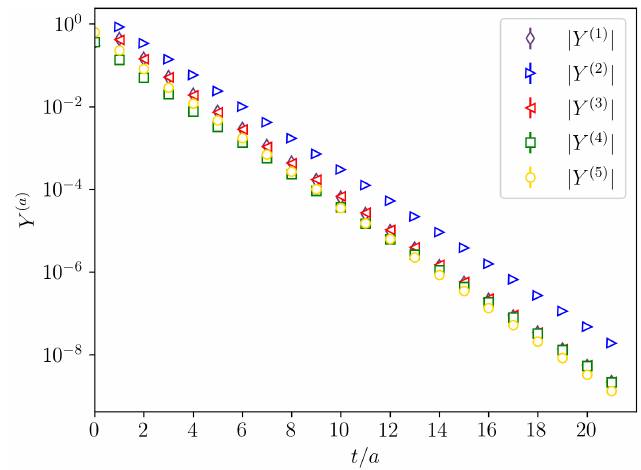
Figure 6 . Time dependence of the correlators Y ( a ) ( t ; q ) for | q | ’ 0 . 5 GeV calculated on the ETMC ensemble B55.32. The error bars are smaller than the point markers on this scale and a similar quality of the numerical signal is observed for the other momentum values considered in this work.